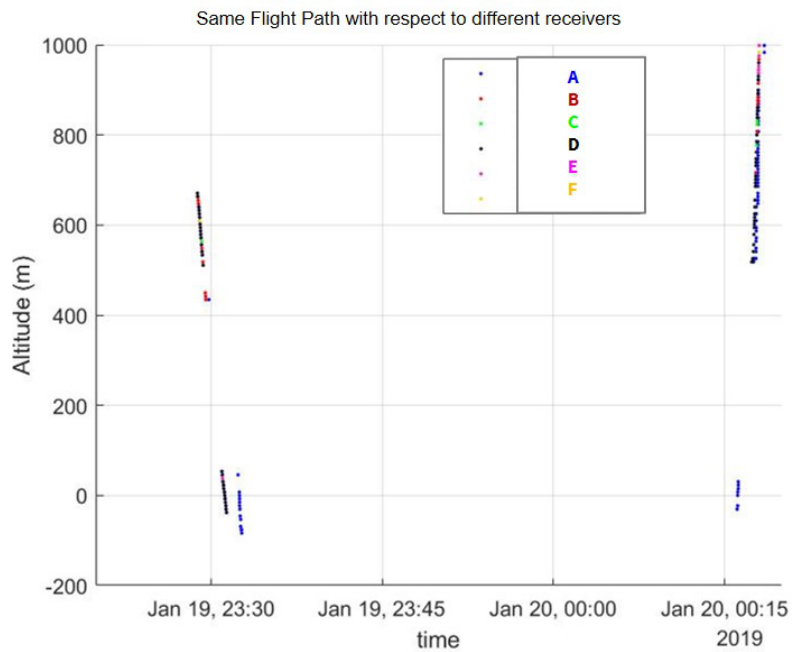
Figure 6. Time versus altitude plot for same flight with respect to different